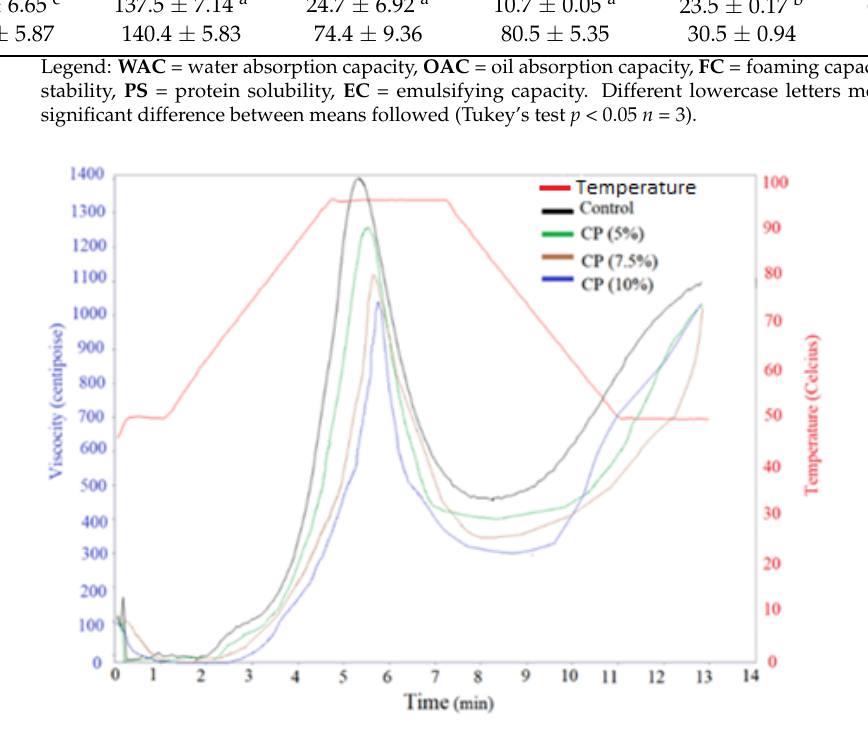
Figure 1. Viscosity profiles of wheat flour with cricket powder (CP) inclusion of 0%, 5%, 7.5%, and 10%, respectively.